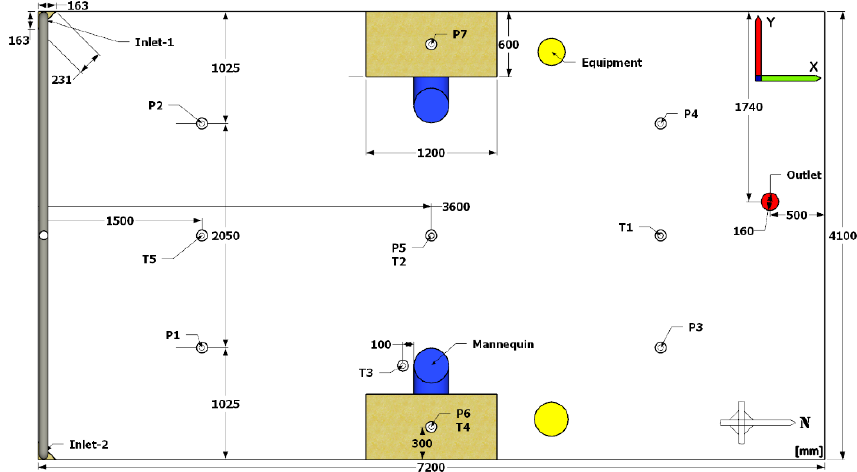
Figure 2. Measurement positions and schematic top-view layout of the office room.